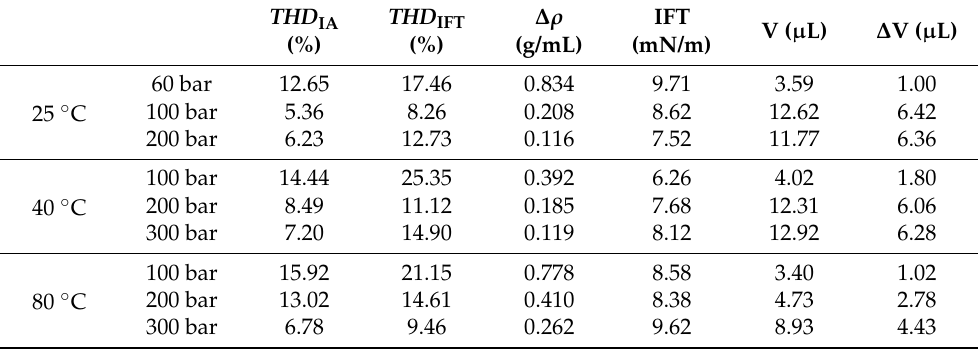
Table 3. THD for the different measurement conditions at frequency 0.5 Hz, where: ∆ ρ is the density difference between the aqueous phase and the CO 2 phase, IFT is the average interfacial tension during oscillations, V is the average droplet size during measurements and ∆ V is the volume amplitude. ∆ THD IA THD IFT (%) (%)